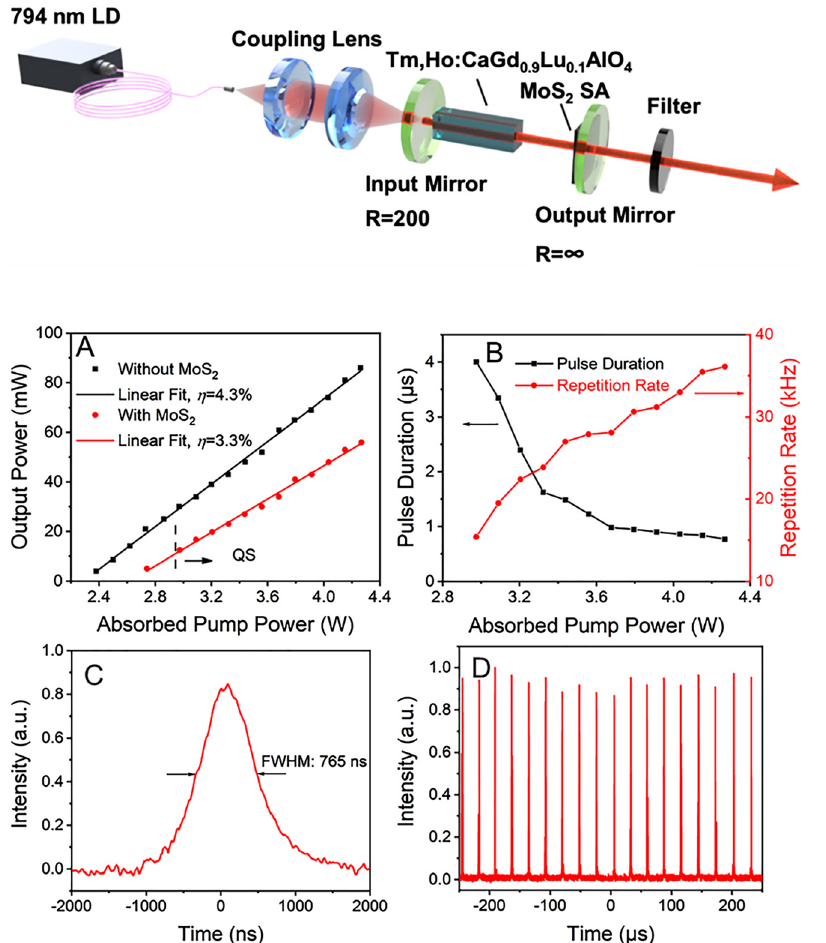
Figure 6: (A) The output power and (B) the pulse duration and the pulse repetition rate versus the absorbed pump power; (C)typicaltemporalpulsepro fi leand(D)the stable pulse train at an absorbed pump power of 4.26